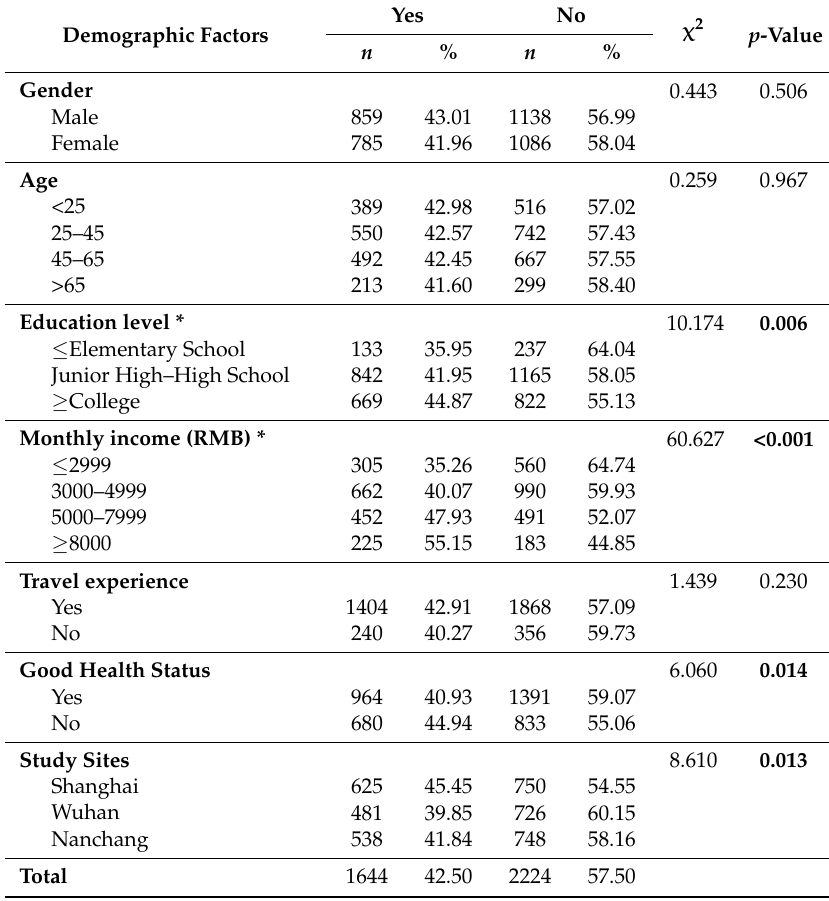
Table 5. Respondents’ knowledge of air pollution related indicator